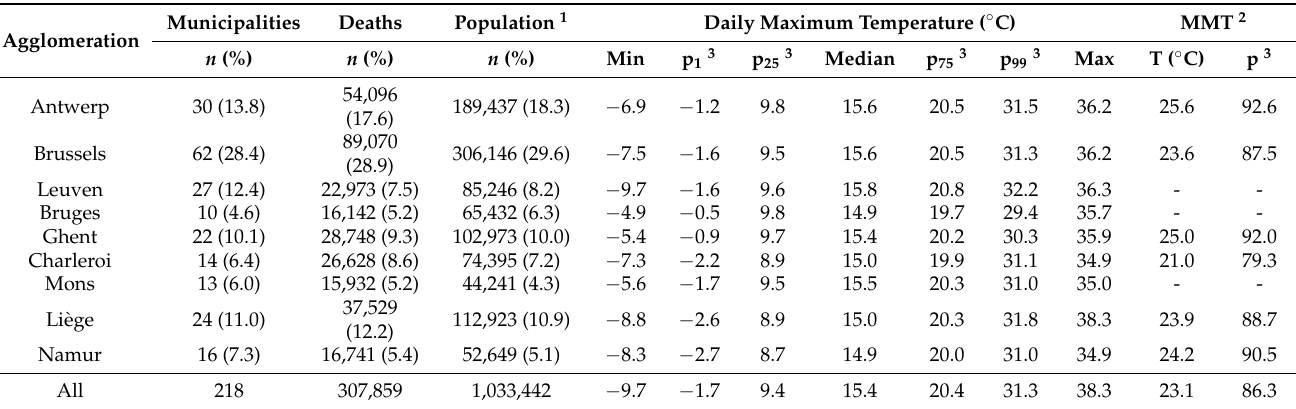
Table 1. Summary statistics of population, mortality, and temperature by agglomeration in